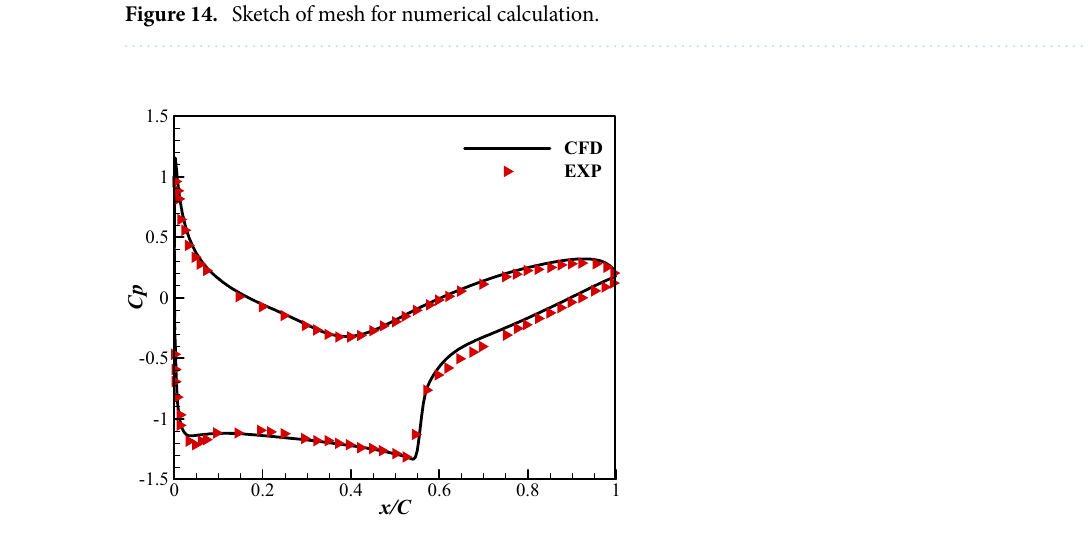
Figure 15. Comparison of CFD and experimental